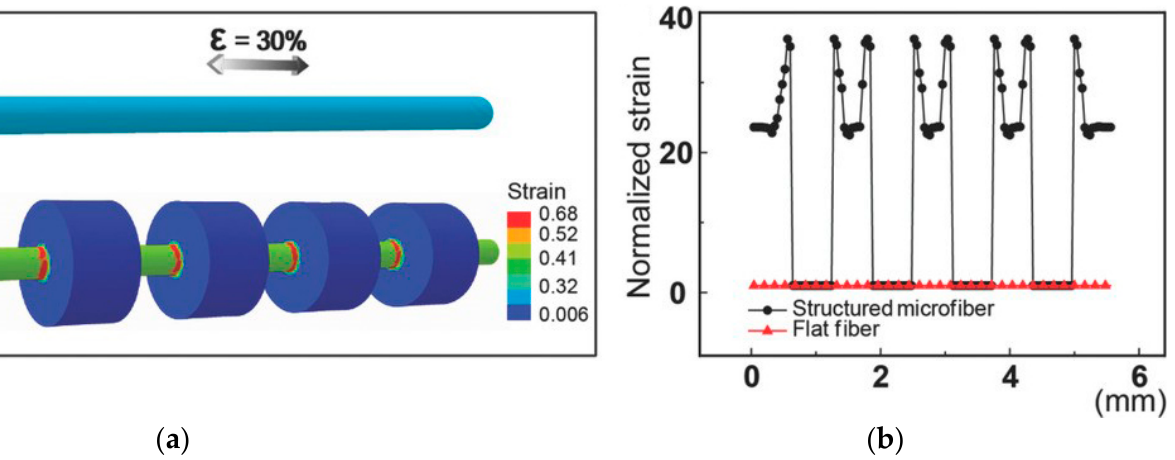
Figure 5. ( a ) Finite element simulation to study the strain adjustment effect of microstructured fibers compared with flat fibers; ( b ) the strain distribution of different structures along the fiber surface [88].